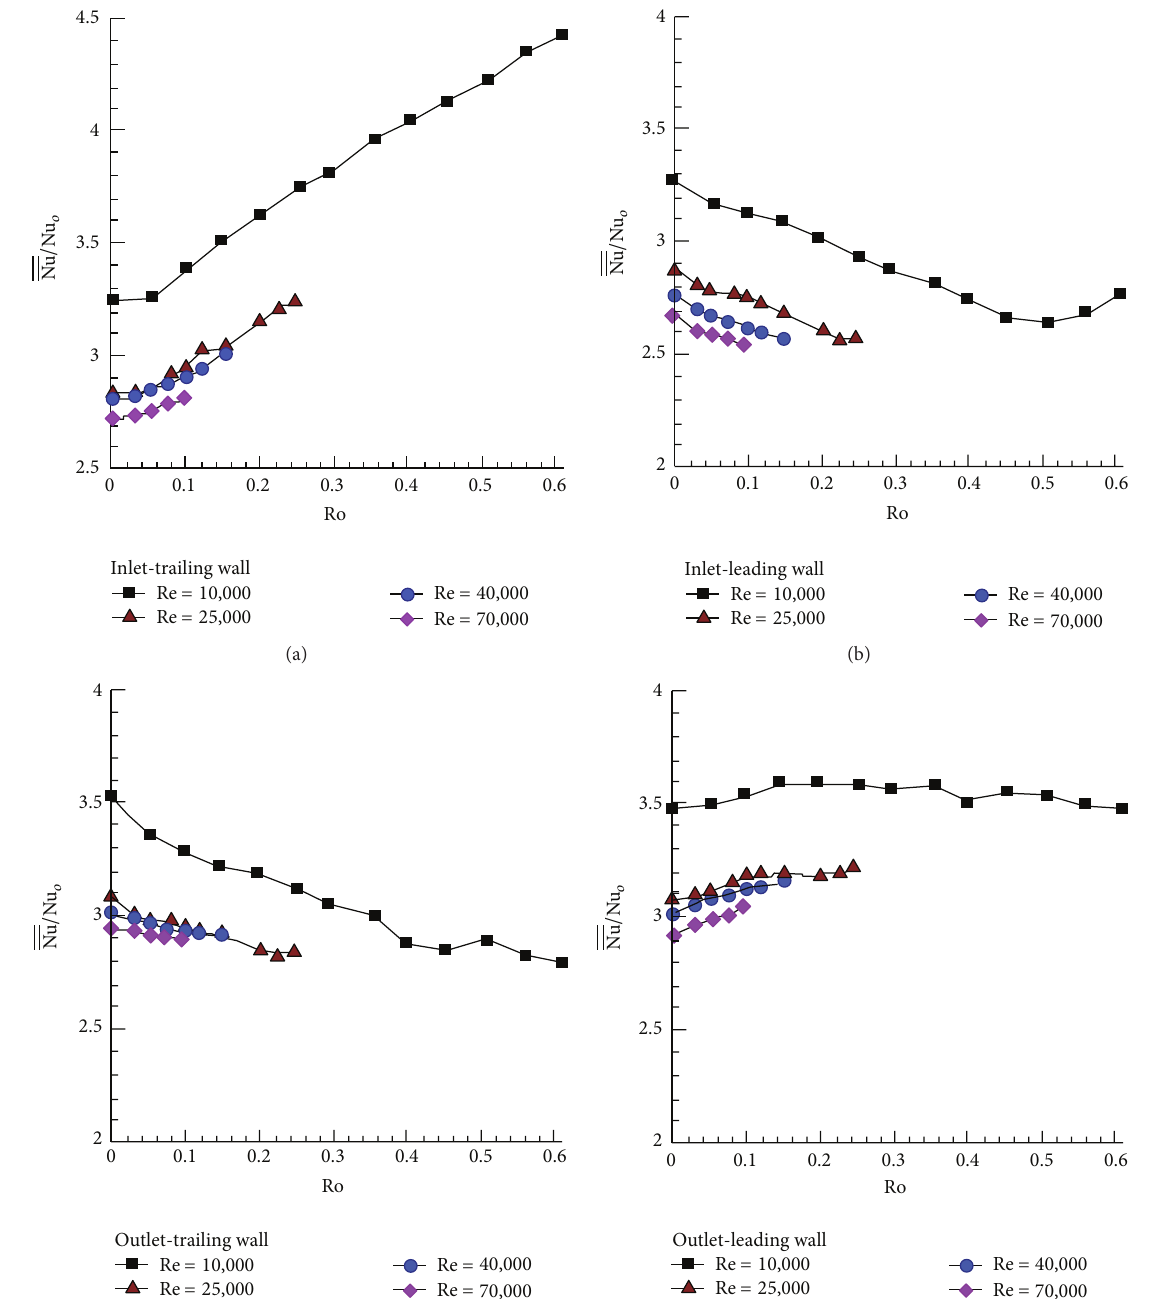
Figure 25: Spatially averaged Nusselt number ratio variations as dependent upon rotation number for the rotating channel investigation of Zhou and Acharya [102]. (a) Radial outflow pressure side results. (b) Radial outflow suction side results. (c) Radial inflow pressure side results. (d) Radial inflow suction side